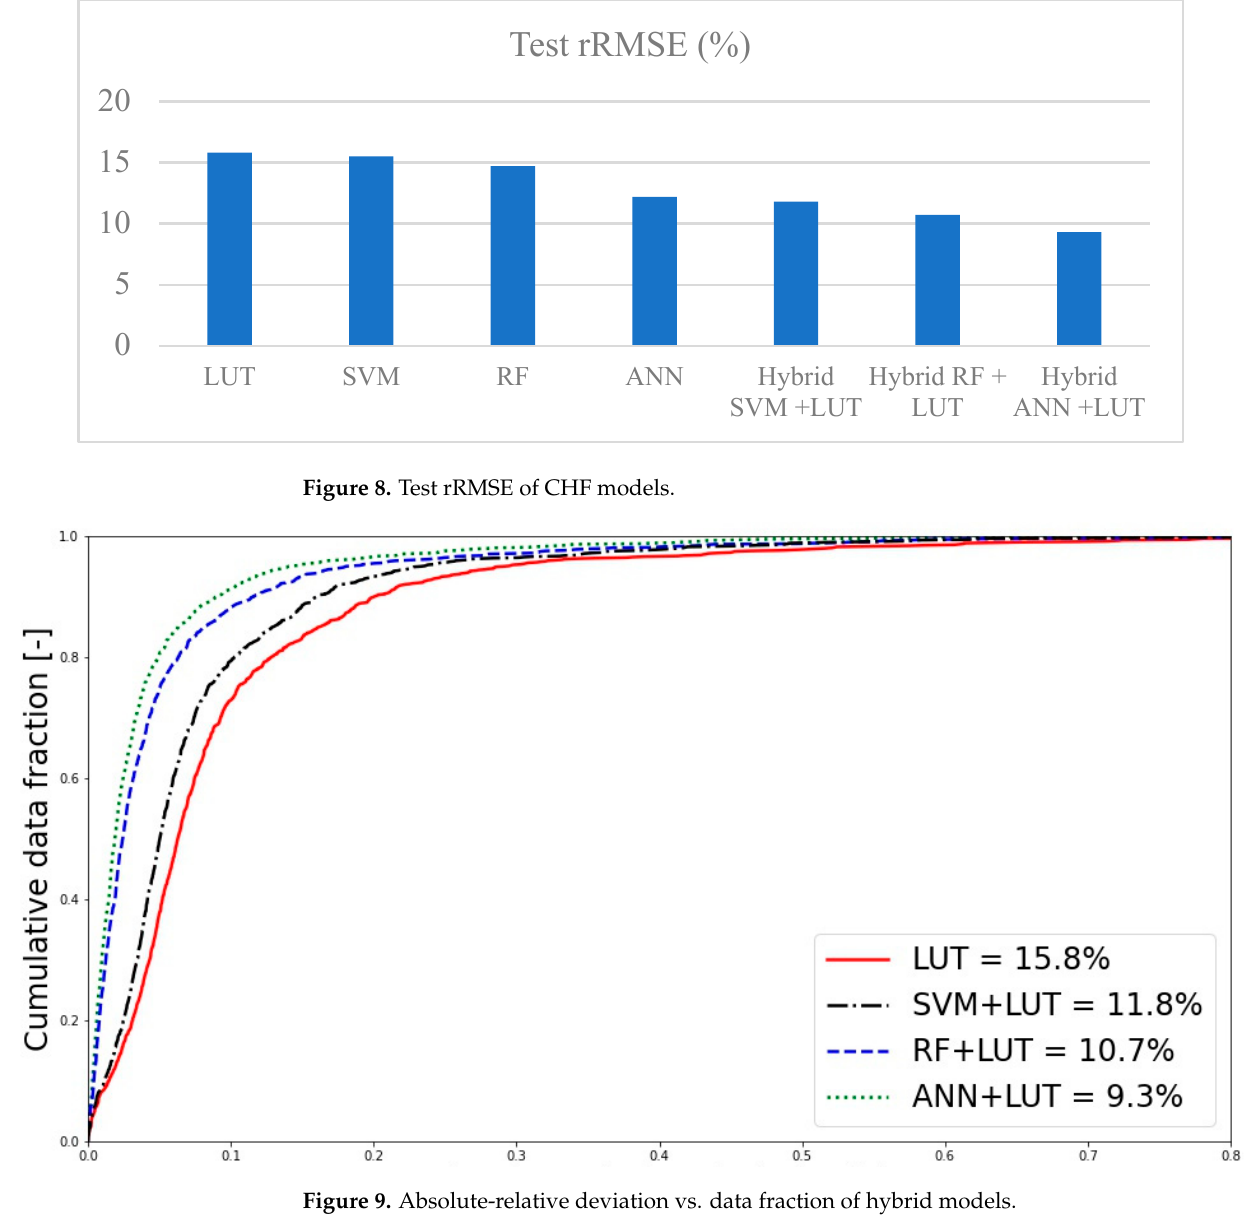
Figure 9. Absolute-relative deviation vs. data fraction of hybrid models .